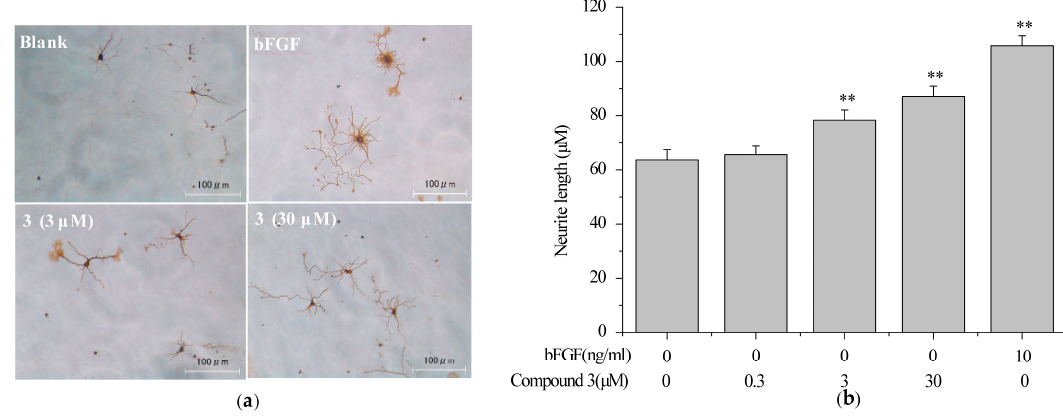
Figure 6. The effect of compound 3 on promoting neurite outgrowth in primary cultured rat cortex neurons. Primary rat cortex neurons were seeded in poly- L -lysine-coated 24-well plates in DMEM for 24 h, then changed to neurobasal medium (2% B27 and 0.5 mM L -glutamine) and exposure to vehicle (0.1% DMSO) as a negative control, bFGF (10 ng/mL) as a positive control, or 3 (0.3, 3, 30 µ M) for an additional six days. Scale bar: 100 µ m. ( a ) Cell morphology was observed and photographed as described in Section 3.8; ( b ) Neurite length was measured as described in Section 3.8. Data are expressed as the mean ± SD from three independent experiments. ** p < 0.01 represent significant differences compared with vehicle (ANOVA followed by Dunnett’s